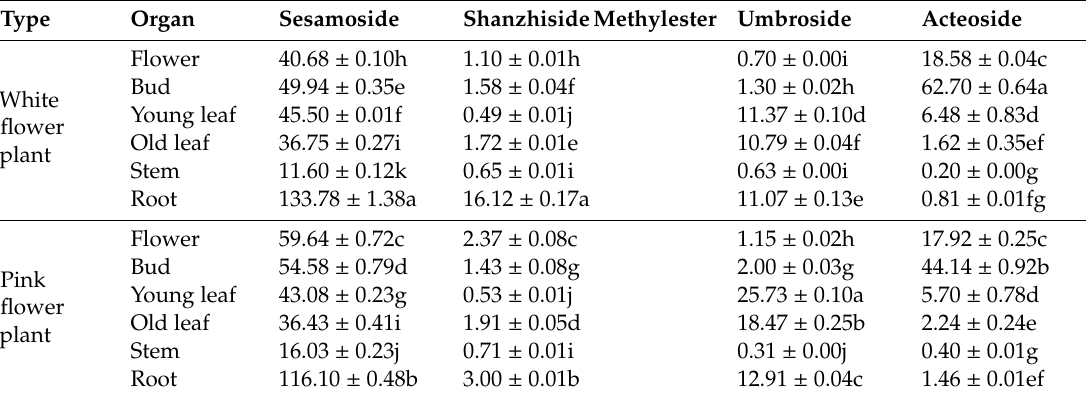
Table 3. The accumulation of terpenoid (iridoid glycosides) in di ff erent organs of di ff erent flower type